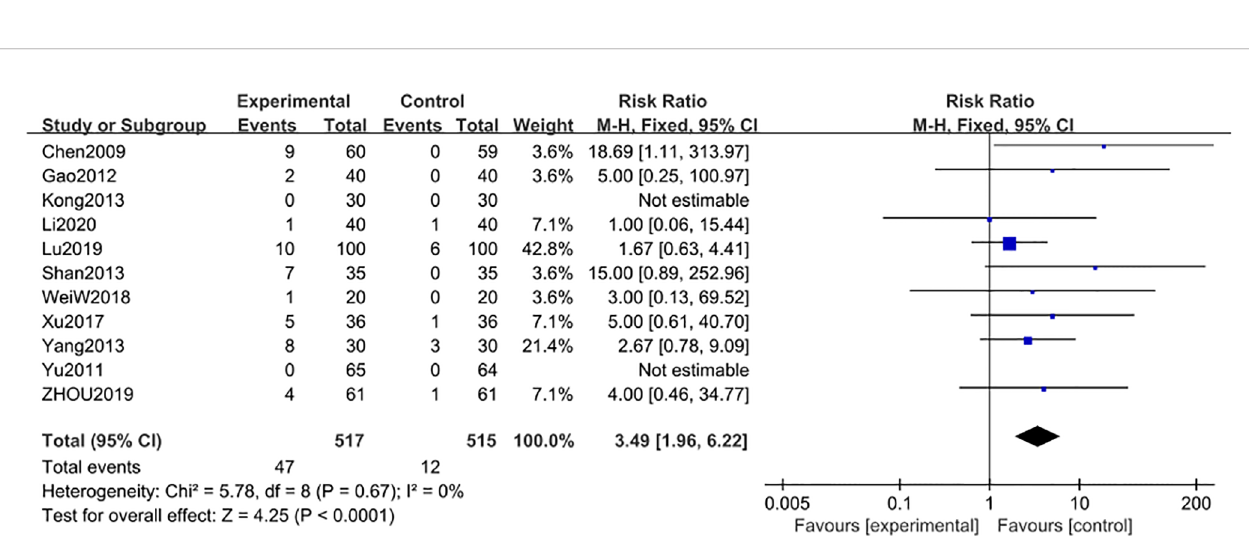
FIGURE 11 | Adverse reaction events after 6 months: comparison of treatment combined with TG against basic treatment.